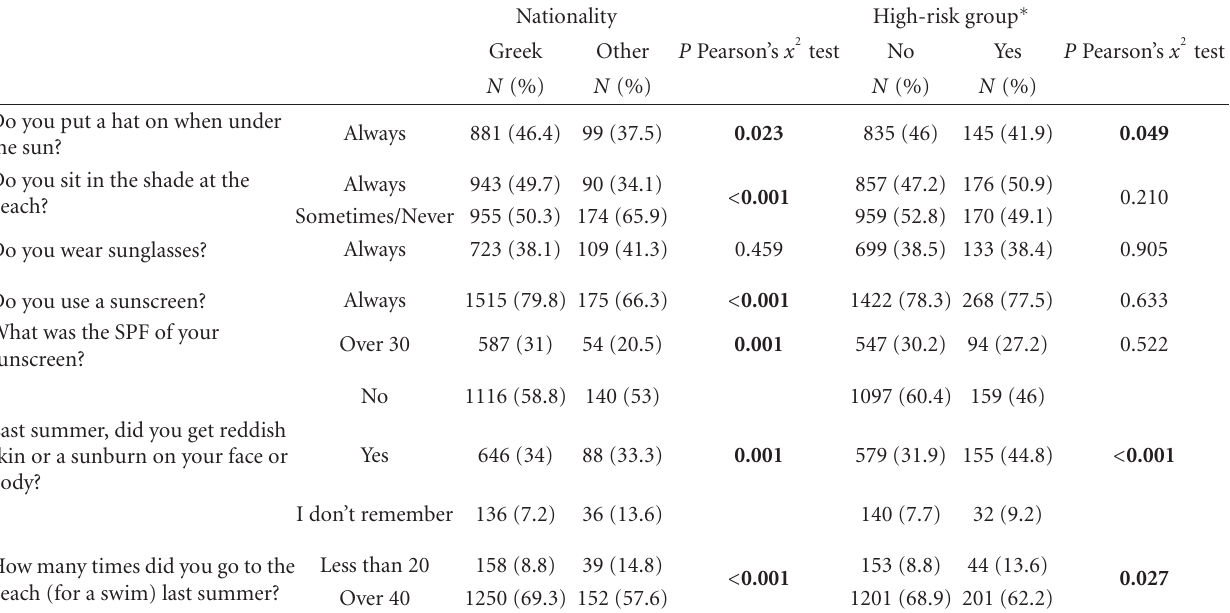
Table 4: Students’ behaviour according to nationality and risk